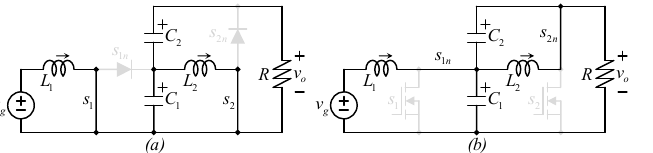
circuits, Figure 3a shows the equivalent circuit of the converter when s x = 1 , both tran- sistors are closed, and diodes are reversely polarized ( s 1n whit V C1 and s 2n with V C1 +V C2 ).